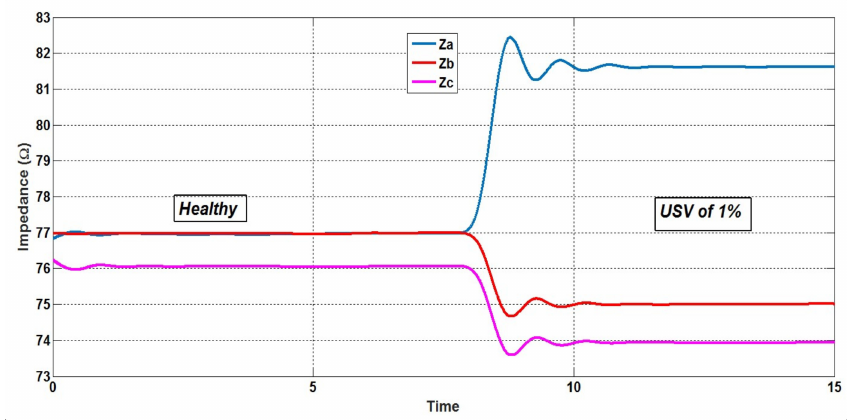
Figure 5. IM estimated Za,b,c for a small USV (1%) at no load.